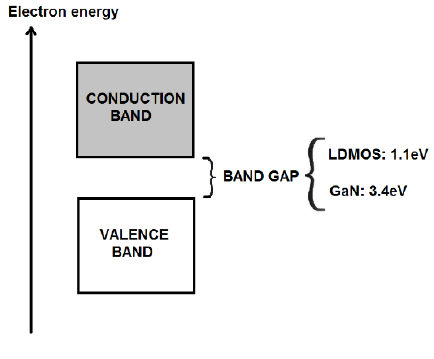
Figure 5. Band gap for LDMOS and GaN.